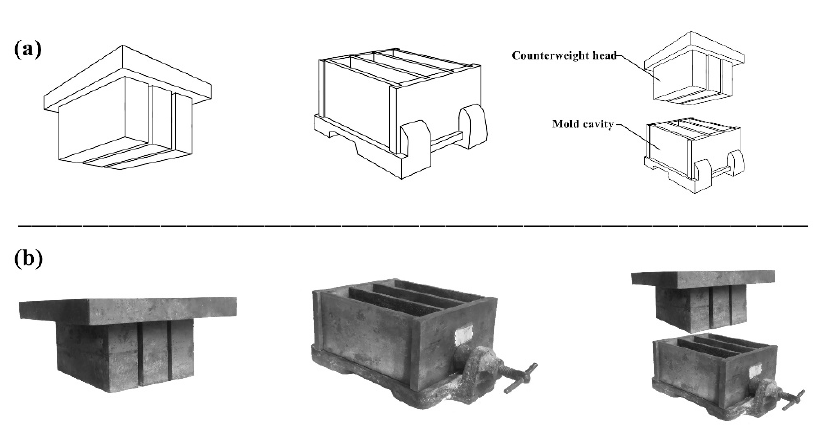
Figure 1. Special mold. ( a ) Design drawing. ( b ) Real mold. Table 2. The mix proportion of resin-based permeable brick